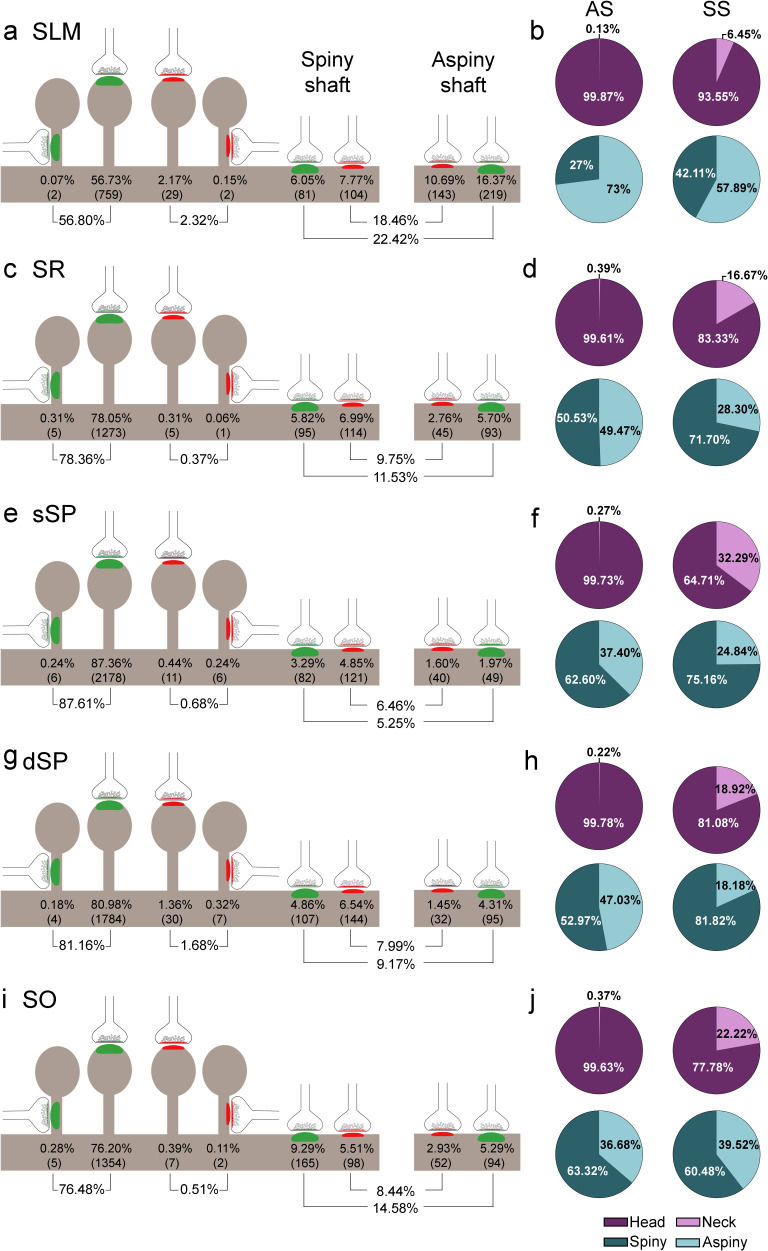
Representation of the distribution of synapses according to their postsynaptic targets in all layers of CA1.(a, c, e, g, i) Shows the percentages of axospinous (both on the head and the neck of dendritic spines) and axodendritic (both on spiny and aspiny shafts) asymmetric synapses (AS; green) and symmetric synapses (SS; red). The numbers of each synaptic type are shown in brackets. (b, d, f, h, j) Pie charts to illustrate the proportions of AS and SS according to their location as axospinous synapses (i.e., on the head or on the neck of the spine) or axodendritic synapses (i.e., spiny or aspiny shafts). SO: stratum oriens; dSP: deep stratum pyramidale; sSP: superficial stratum pyramidale; SR: stratum radiatum; SLM: stratum lacunosum-moleculare. See related Figure 5—figure supplement 1 for further information.